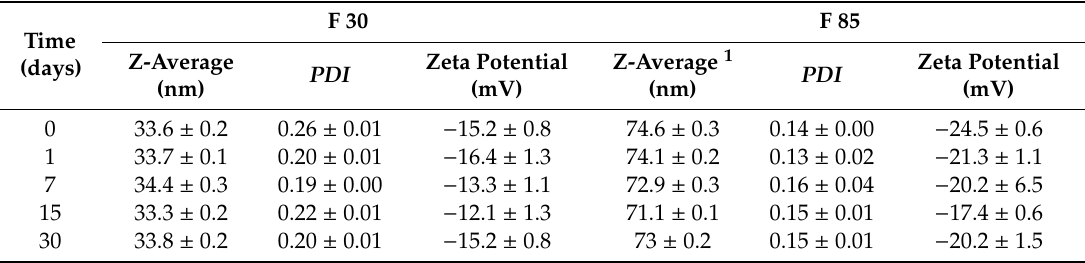
Physico-chemical characterization of optimized Ucu ù ba fat NLC during storage at room temperature.